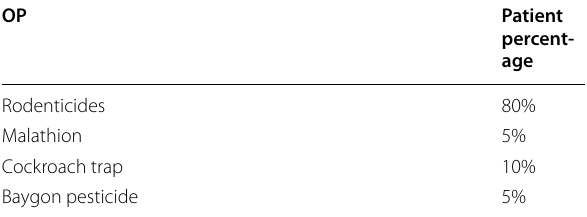
Table 1 The distribution of the acute organophosphate poison‑ ings according to the responsible